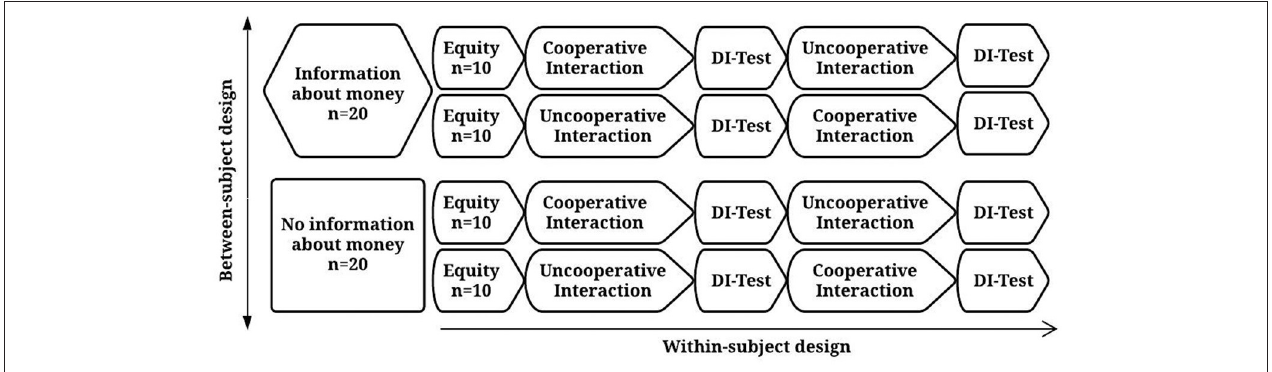
FIGURE 3 | Flowchart of experimental design and conditions order of exposure. Experimental design consisted of a within group design, in which half of the participants ( n = 20) received information that points would be exchanged for money and the other half ( n = 20) did not (left hexagon and rectangle), and within-subject design as participants from both groups were exposed to cooperative and uncooperative interaction in different